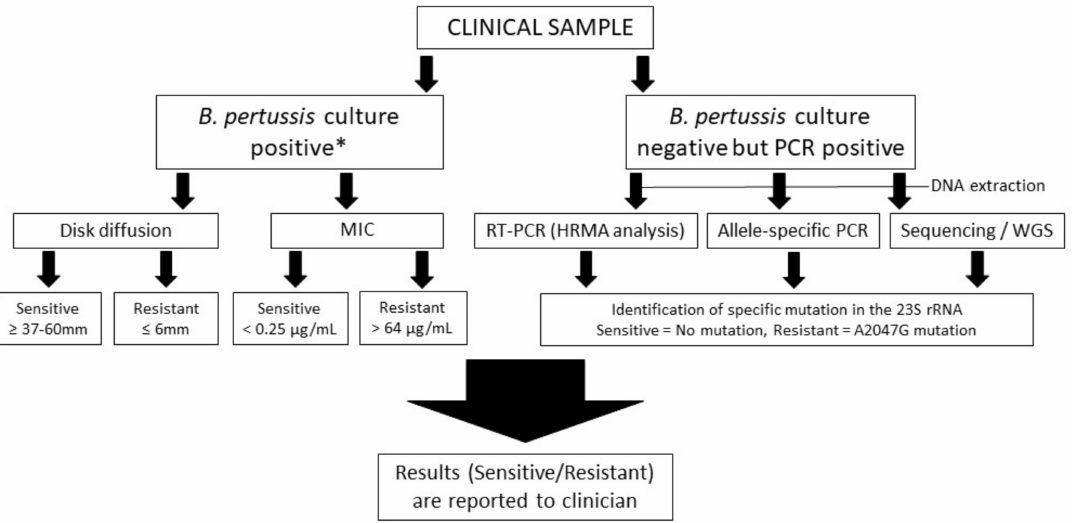
Figure 3. A flow chart of sample processing to detect macrolide-resistant B. pertussis . * The A2047G mutation can also be detected from the culture-positive clinical samples by DNA extraction and following the procedure for B. pertussis culture-negative but PCR-positive